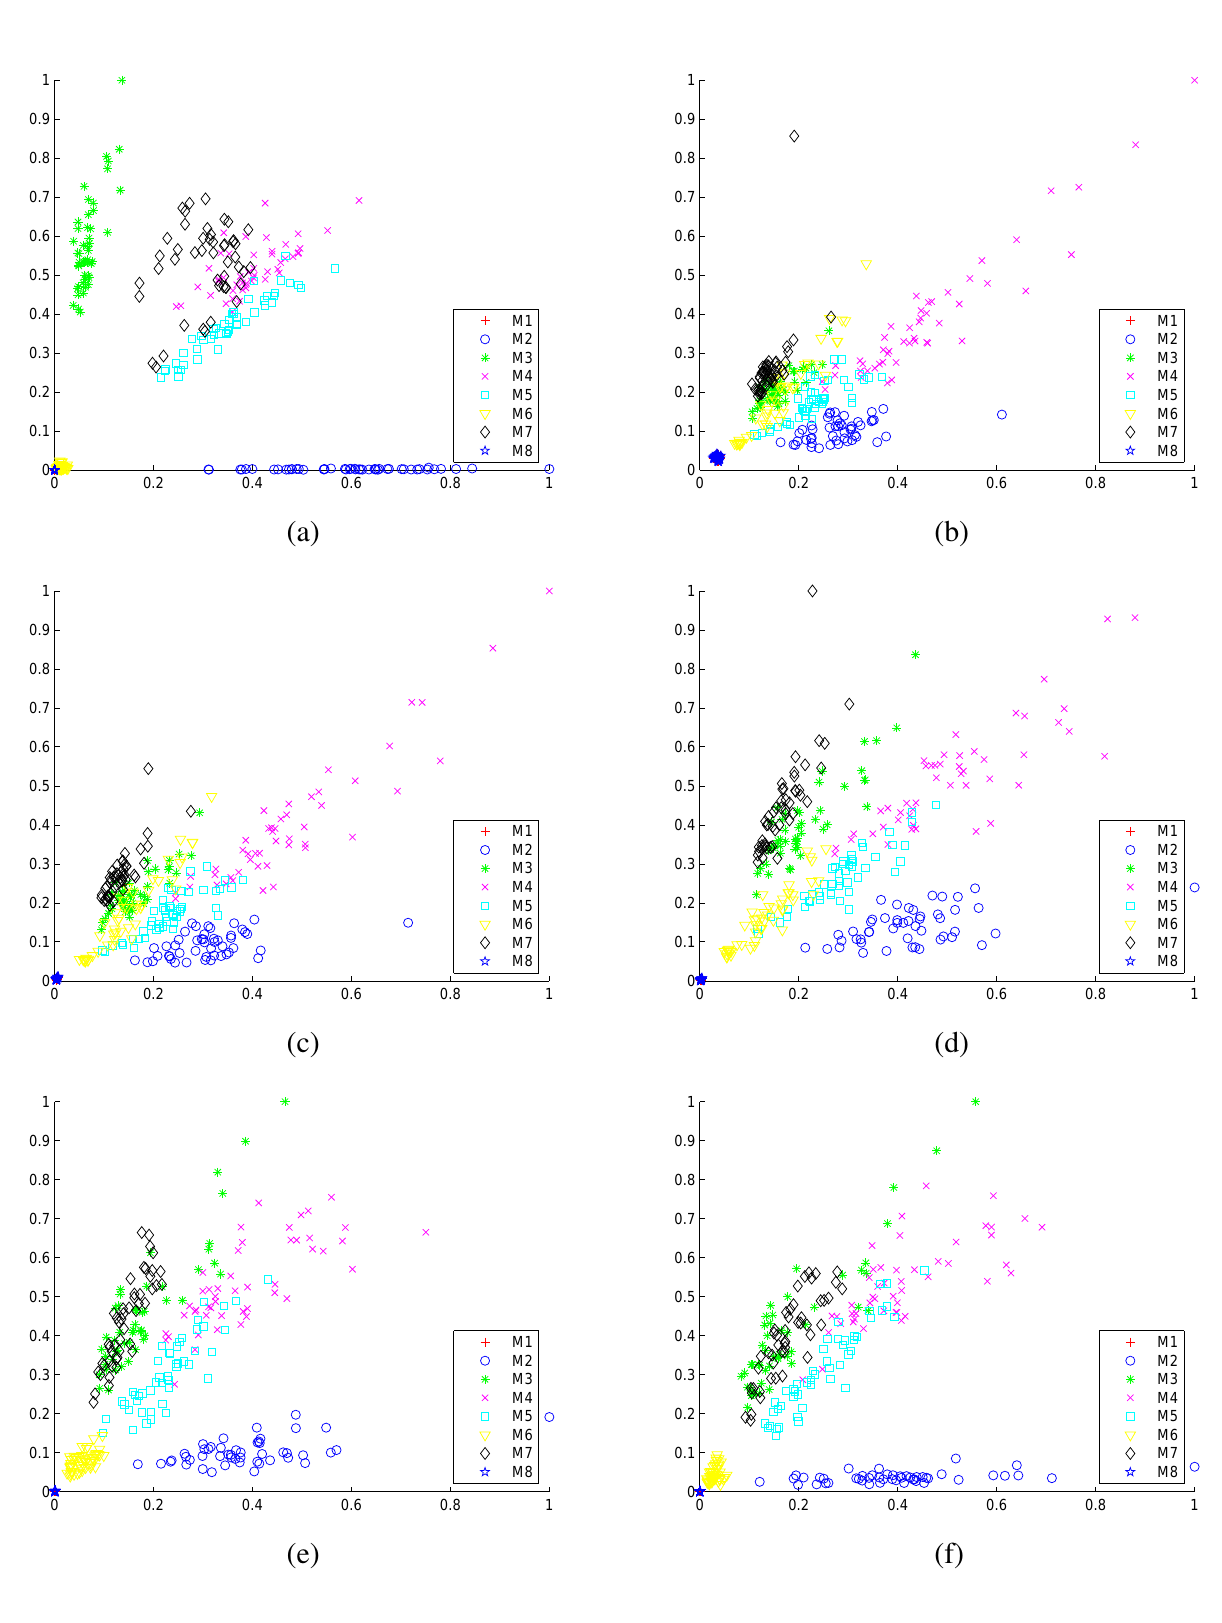
, (b) D , (c) D , (d) D , (e) D , 5 1 2 3 4